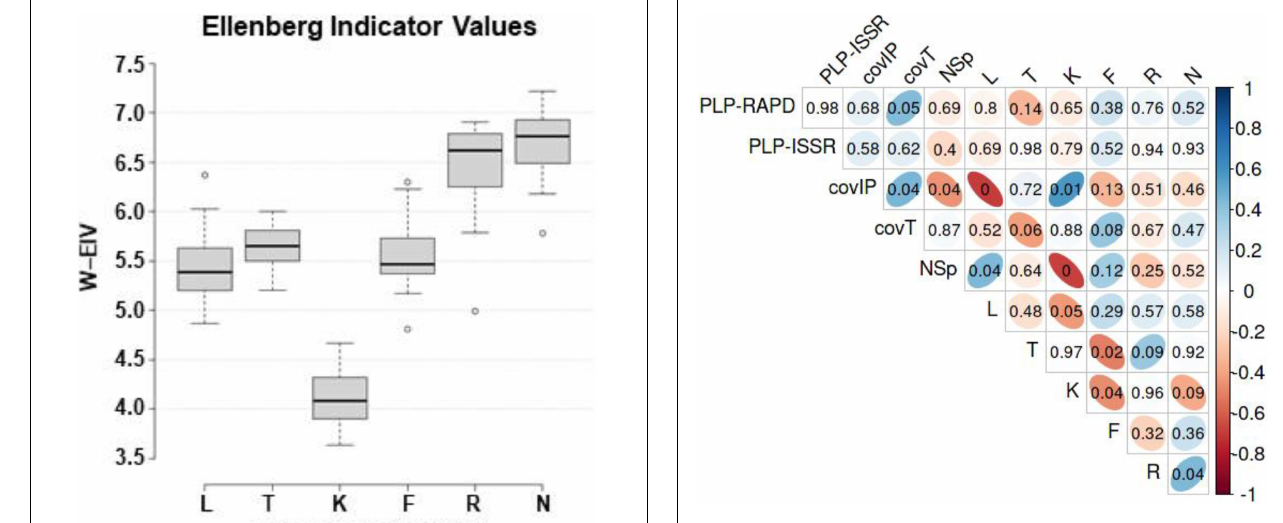
FIGURE 11 | The correlogram represents the Spearman correlation coefficients (Rs) from –1 to 1 for all pairs of variables in the sites with Impatiens parviflora . Blue color represents positive and red color represents negative correlations. The intensity of the color indicates the strength of the correlation, so the stronger the correlation, the darker the figures. Correlations numbers inside colored figures indicate the level of significance, thin ellipsoid figures show significant ( P < 0.05), figures toward spherical shape – insignificant correlations. PLP-RAPD, percentage of polymorphic loci at randomly amplified polymorphic DNA; PLP-ISSR, percentage of polymorphic loci at inter simple sequence repeats; covIP, coverage by I. parviflora ; covT, total coverage by herbaceous plant species; NSp, number of herbaceous plant species; L, light; T, temperature; K, continentality; F, soil moisture; R, soil reaction; N, nutrients as weighted Ellenberg indicator values